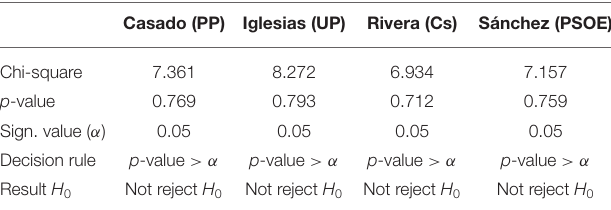
TABLE 3 | Chi-squared test results considering the observed frequencies for each emotion showed by every candidate. Casado (PP) Iglesias (UP) Rivera (Cs) Sánchez (PSOE)